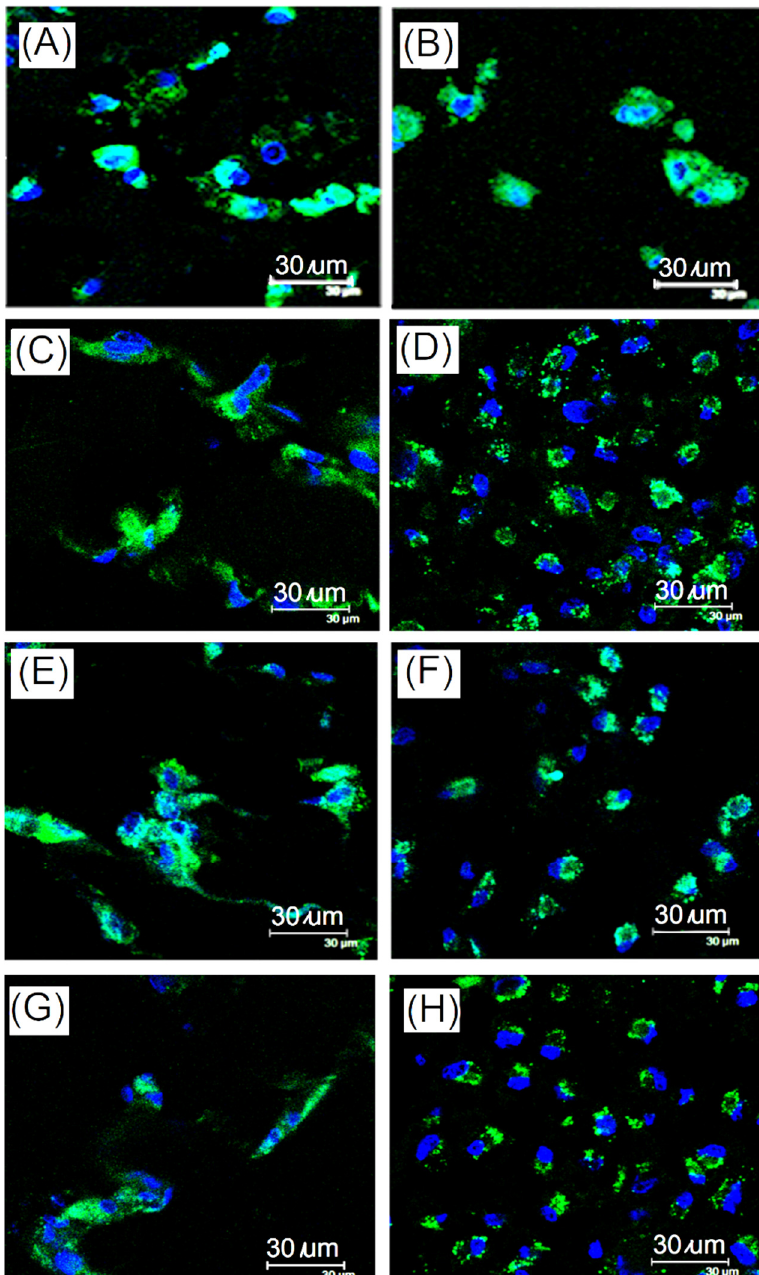
Figure 13. Immunofluorescence staining of expression from chondrocytes grown on EDC-crosslinked gelatin-based hydrogel scaffold in dynamic culture system for collagen type II ( A ) after 21 days and ( B ) after 28 days (blue-Nuclei and green-collagen type II); for MMP13 ( C ) after 21 days and ( D ) after 28 days (blue-nucleus and green-MMP13); sox9 ( E ) after 21 days and ( F ) after 28 days (blue-nucleus and green-sox9); and aggrecan ( G ) after 21 days and ( H ) after 28 days(blue-nucleus and green-aggrecan) (scale bar, 30 μ m).